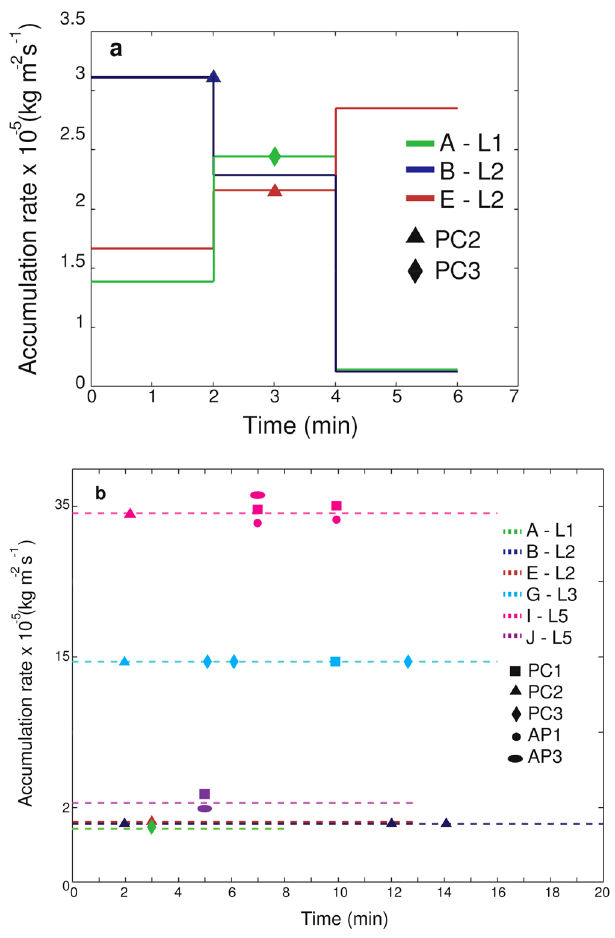
Figure 5. Accumulation rates as a function of time since the beginning of the fallout and timing of observed aggregate types. ( a ) Accumulation rate for three eruptions (A, B, E) based on multiple-tray collection during the same fallout and ( b ) average accumulation rate based on cumulative collection in a single tray for six eruptions (A, B, E, G, I and J). Different symbols indicate different aggregate types (PC1—square, PC2—triangle, PC3— rhombus, AP1—circle, AP3—ellipsoid). Time = 0 corresponds to the beginning of fallout at individual sites and beginning of ash accumulation in